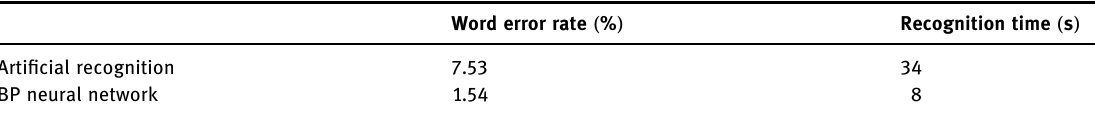
Table 1: The word error rate and recognition time of the BP neural network and the arti fi cial recognition